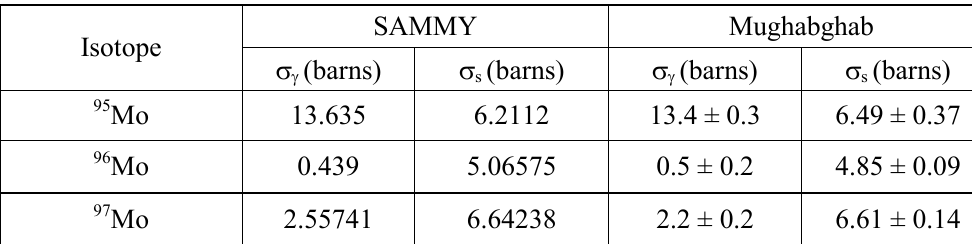
Table V. Comparison of thermal cross sections at 0.0253 eV